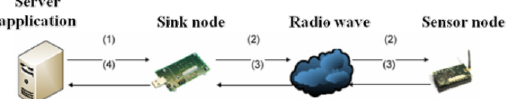
Figure 4. Wireless connection between a sensor node and a server computer.